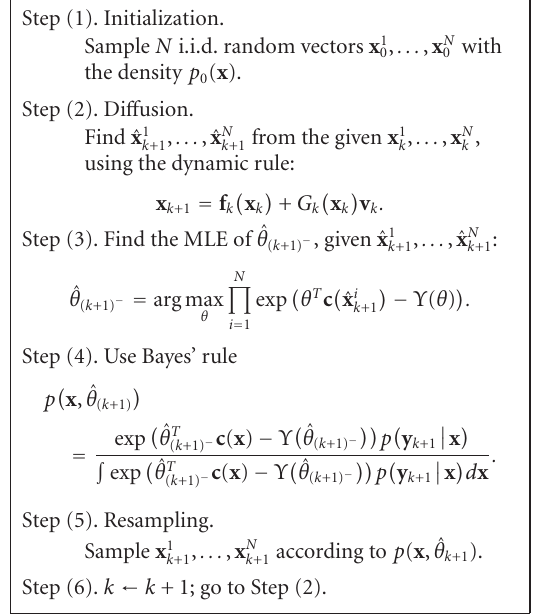
Algorithm 2: Projection particle filtering for an exponential family of